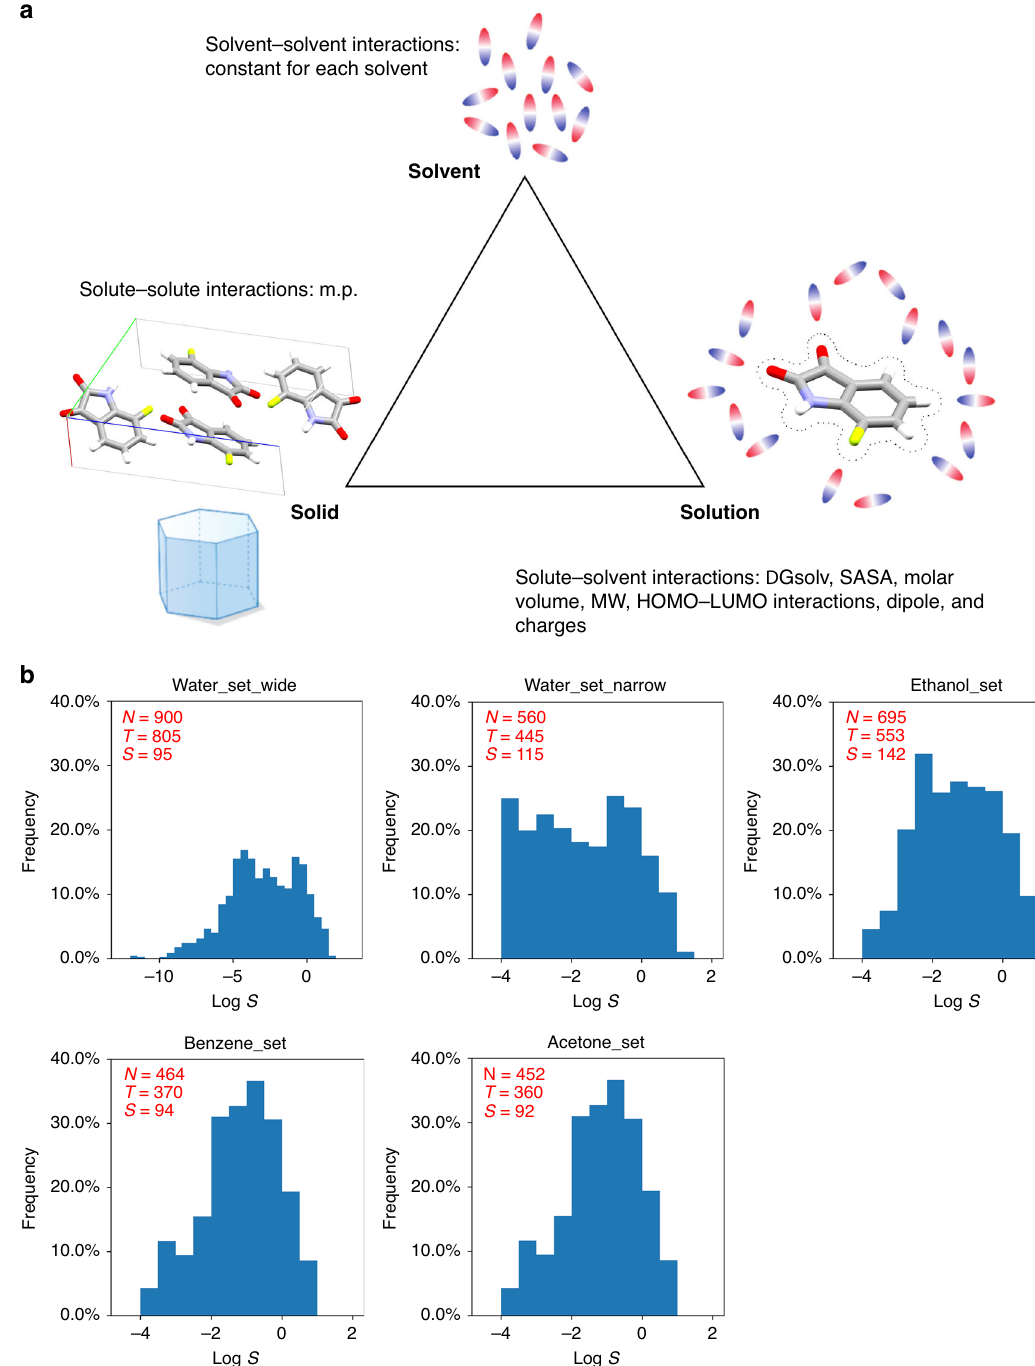
Fig. 1 Concepts of solubility prediction and data availability. a Physical aspects of dissolution process of solid and corresponding descriptors. b Curated solubility datasets for this study and their LogS distributions ( N = number of datapoints, T = number of datapoints in training set, S = number of datapoints in test